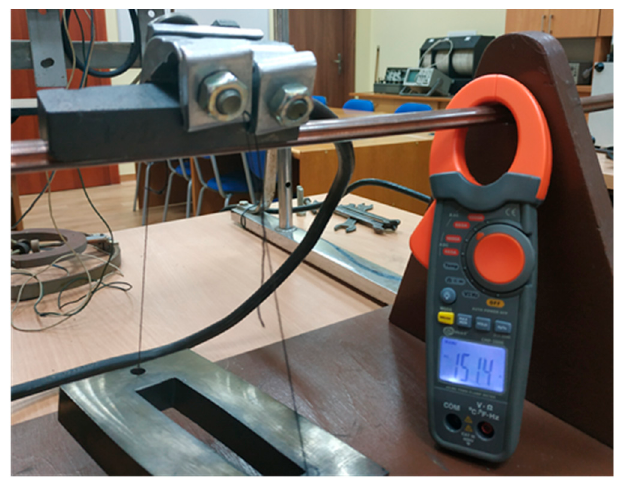
Figure 4. A photograph of the laboratory stand for testing current ampacity.